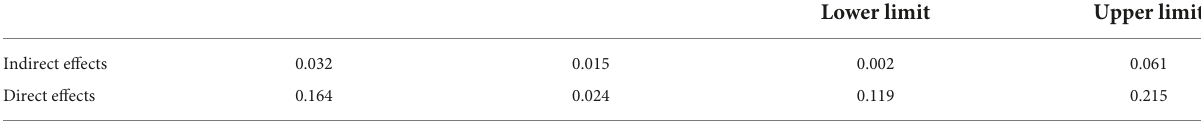
TABLE 4 Bootstrap test of mediating